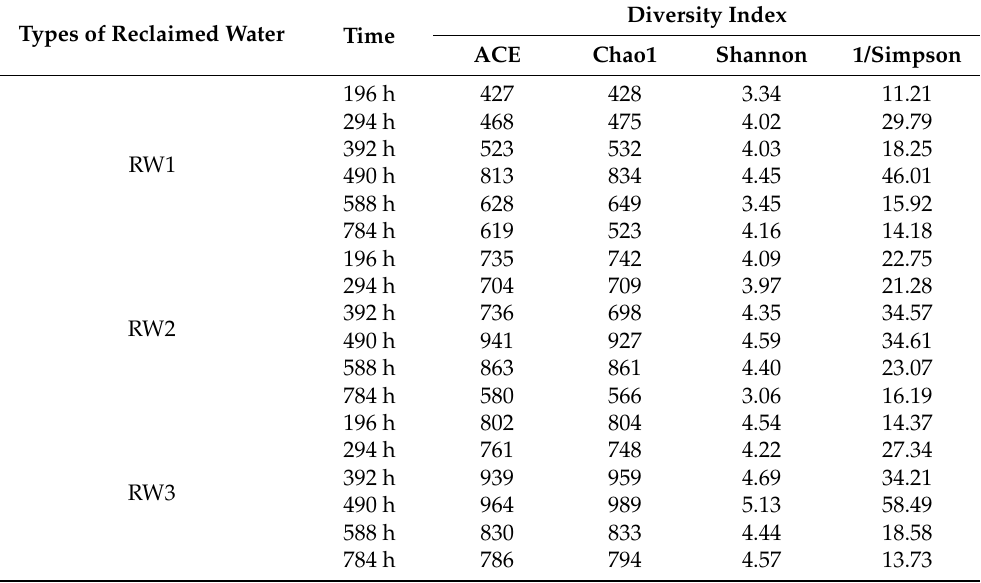
Table 1. Diversity index of microbial community in